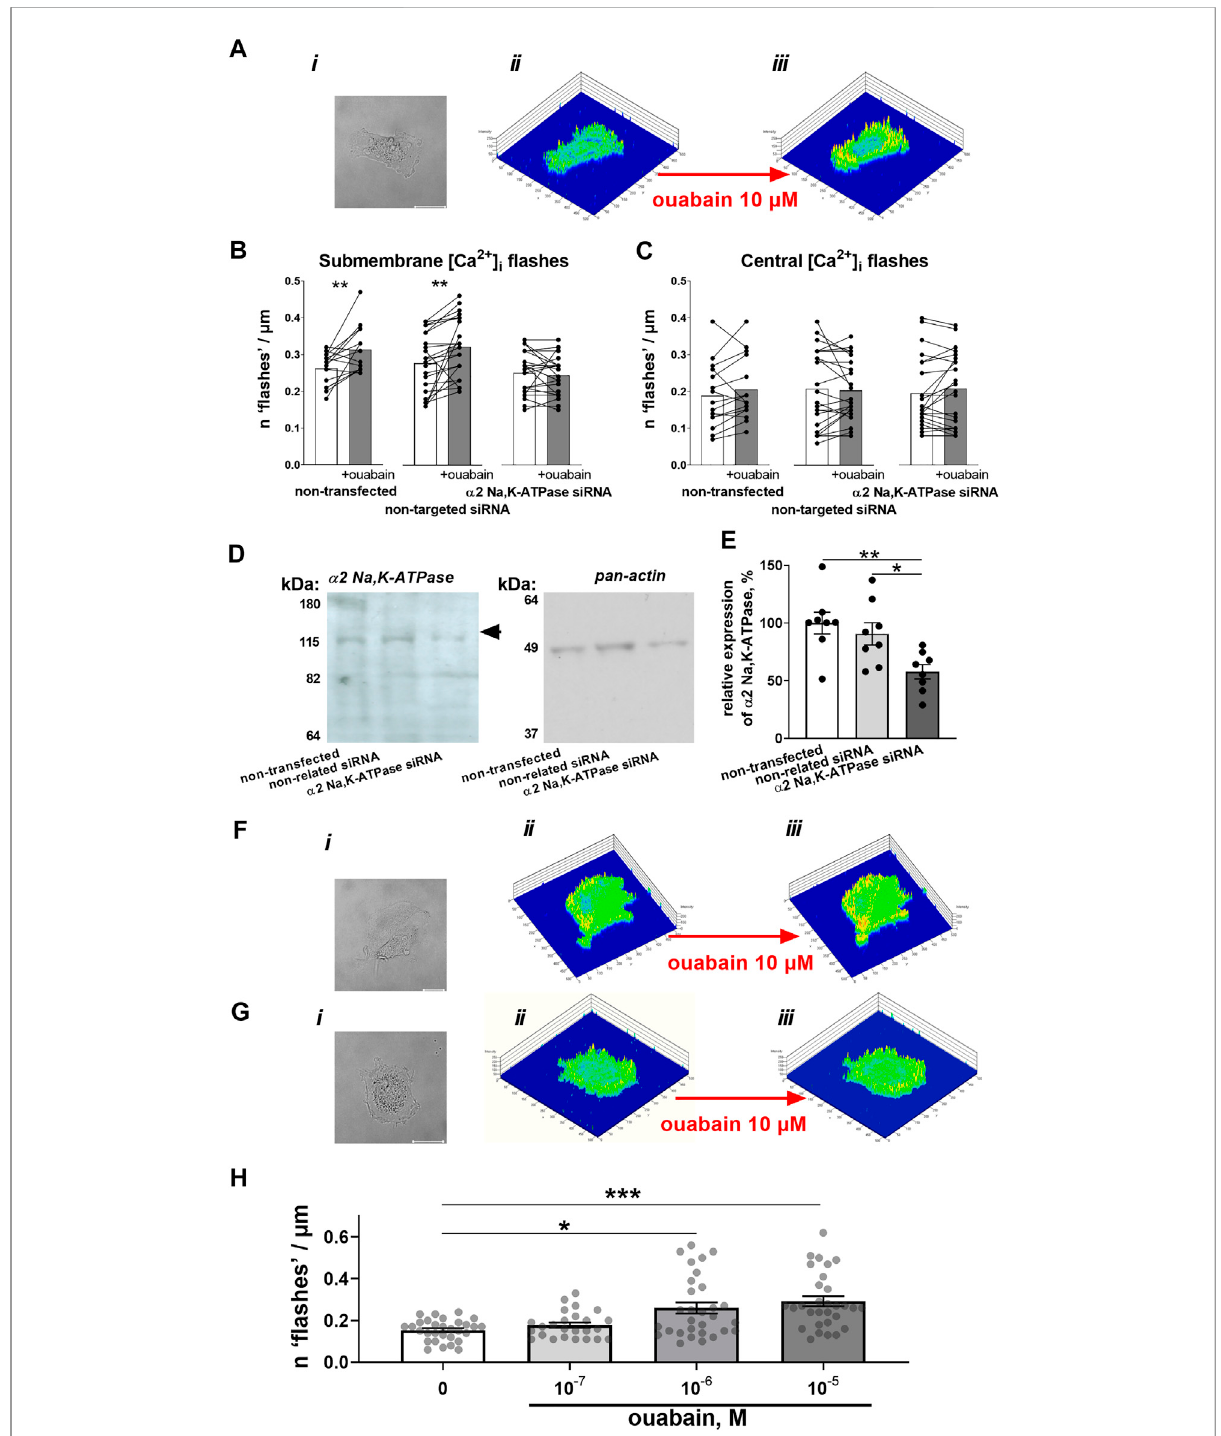
FIGURE 1 OuabaininducesCa 2+ fl ashesthatdependontheexpressionofthe α 2isoformNa,K-ATPase.A7r5cells( A i )wereloadedwithCa 2+ sensitivedyes, Calcium Green-1 and Fura Red, which ratio represents relative intracellular Ca 2+ changes. This ratio was assessed under control conditions ( A ii ) and after incubation with 10 µM ouabain ( A iii ). Exposure to ouabain induced signi fi cant elevation of submembrane Ca 2+ fl ashes in non-transfected cells ( n = 15 of 3 cultures) and cells transfected with non-targeted siRNA ( n = 25 of 3 cultures), while cells transfected with siRNA directed against α 2 isoform Na,K-ATPase did not show any changes ( n = 22 of 3 cultures) (B) . No signi fi cant changes of intracellular Ca 2+ activity in the center of